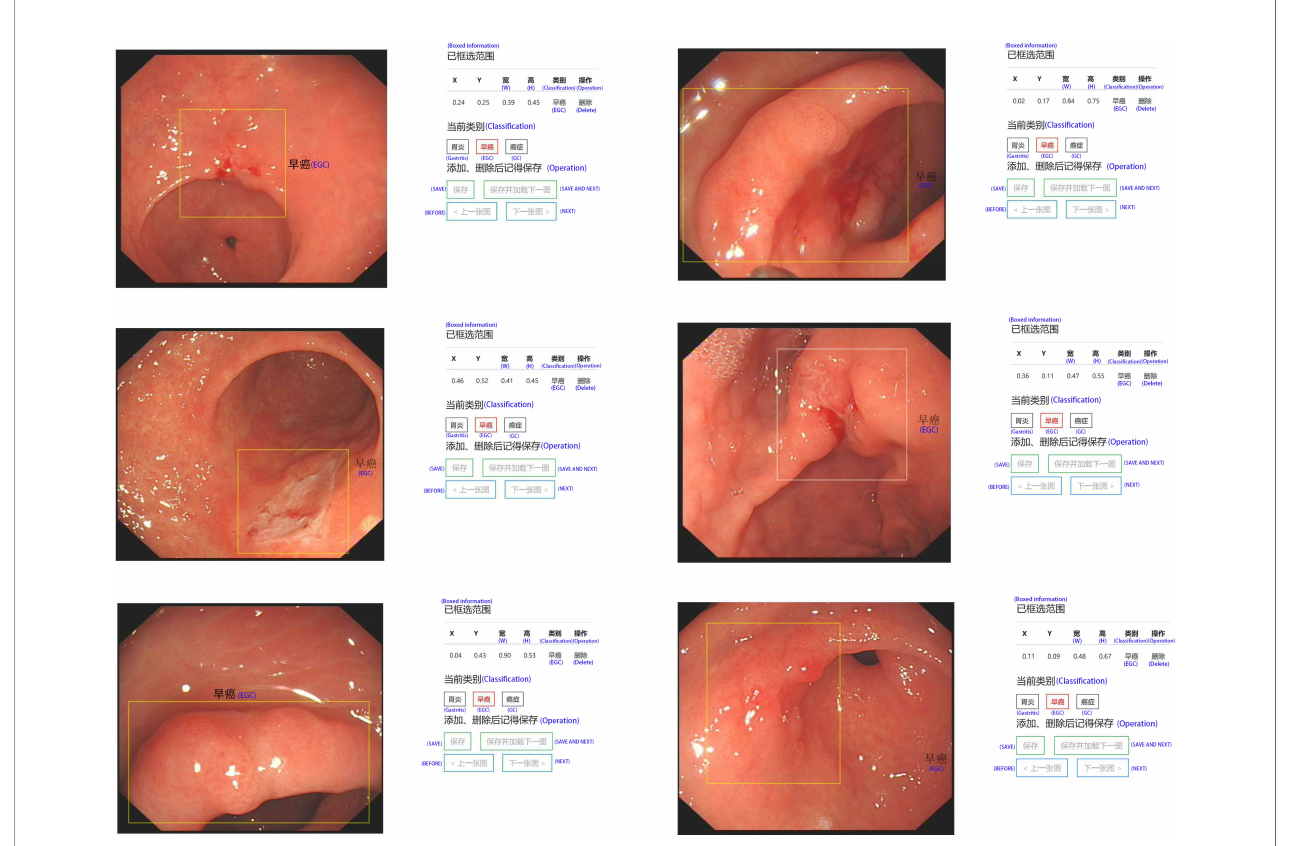
FIGURE 3 | Online labeling of early gastric cancer lesions at 6 different sites.